Question: Generate an informative caption for the figure above.
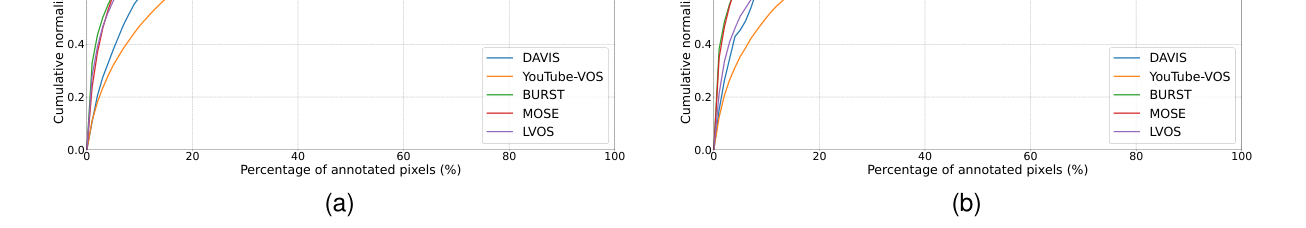
Answer: Cumulative frequency graph of target box areas (expressed as percentages of the total image area) for different datasets. (a) displays the cumulative frequency graph based on annotations from all frames. (b) shows the cumulative frequency graph of the first frame annotations.